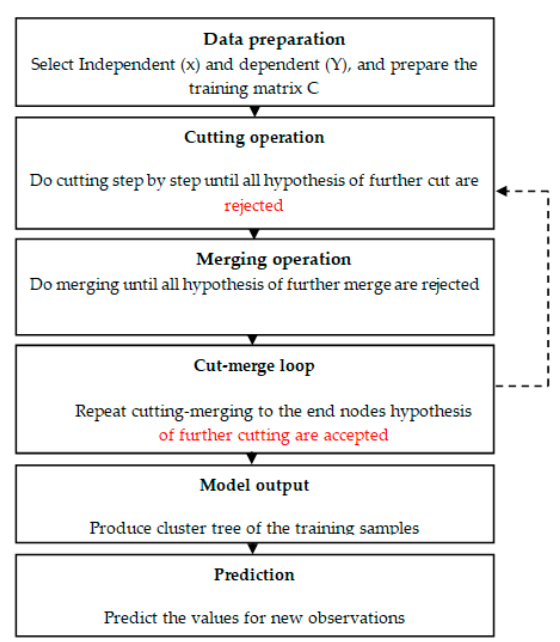
Figure 3 . Flow chart of Stepwise cluster analysis (SCA) Figure 3. Flow chart of Stepwise cluster analysis